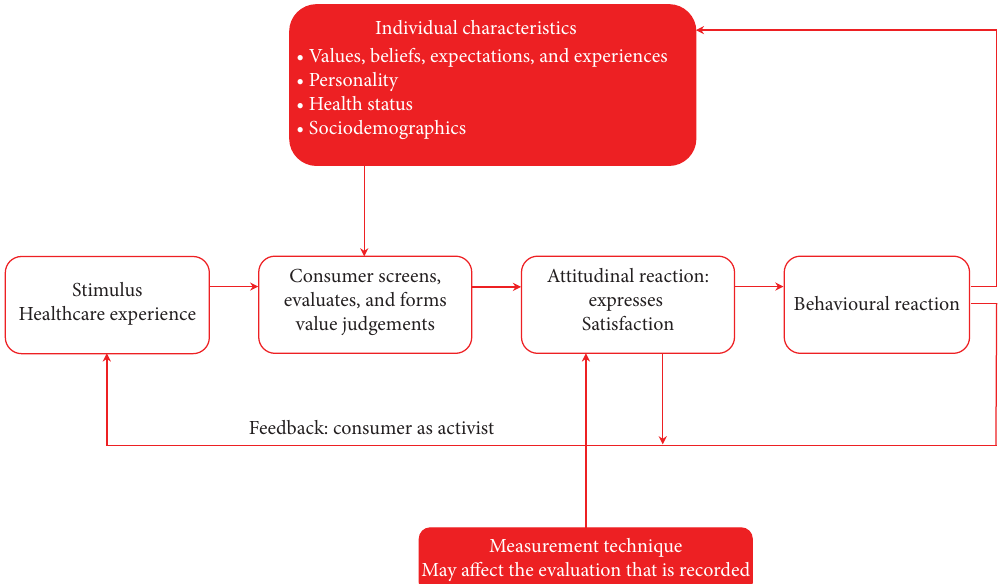
Figure 2: Holistic model of satisfaction with healthcare (adapted from Strasser and Davis [59] and Strasser et al.